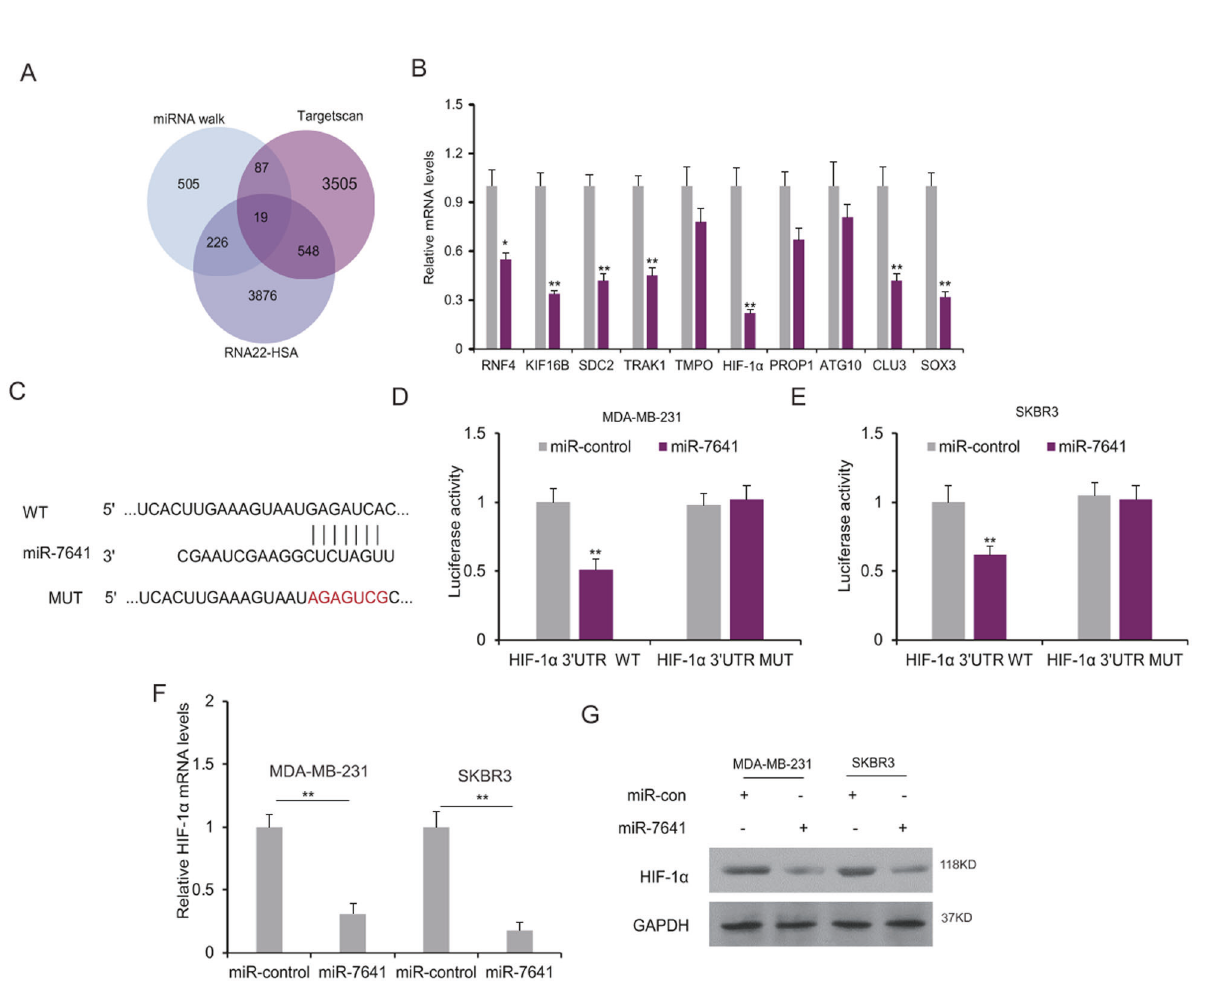
Fig. 5 MiR-7641 regulated HIF-1 α expression in breast cancer cells. A The target gene of miR-7641 was predicted using miRNA walk, Targetcan, and RNA22-HAS. B miR-7641 suppressed target gene expression in breast cancer cells. The expression of the possible target genes of miR-7641 was analyzed by real-time RT-PCR. C The predicted target sequence of HIF-1 α and the mutated sequence of HIF-1 α . D , E MiR-7641 suppressed the luciferase activity of HIF-1 α in MDA-MB-231 and SKBR3 cells. Cells were transfected with miR-7641 mimics and plasmids with luciferase reporters and the luciferase activity was assayed by a dual-luciferase reporter system. F miR-7641 suppressed HIF-1 α mRNA levels in breast cancer cells. Cells were transfected with miR-7641 mimics for 48 h, and total RNA was isolated for real-time RT-PCR analysis. G HIF-1 α protein levels in breast cancer cells with miR-7641 overexpression. Cells were transfected with miR-7641 mimics for 48 h, and total protein was isolated for western blotting. * p < 0.05, ** p < CONCLUSIONS in the presence of NFs derived sEVs with higher levels of miR- The fi ndings showed that CAFs-sEV involved in cancer stem cell 7641, breast cancer cell proliferation, stem cell properties, and phenotype in the tumor microenvironment. It was demonstrated glycolysis were suppressed via down-regulating HIF-1 α expression that exosome miR-7641 was an important player in the commu- (Fig. 7). The study suggested that introduction of miR-7641 in nication between breast cancer cells and the cellular component breast cancer cells could be a new way to treat breast cancer.